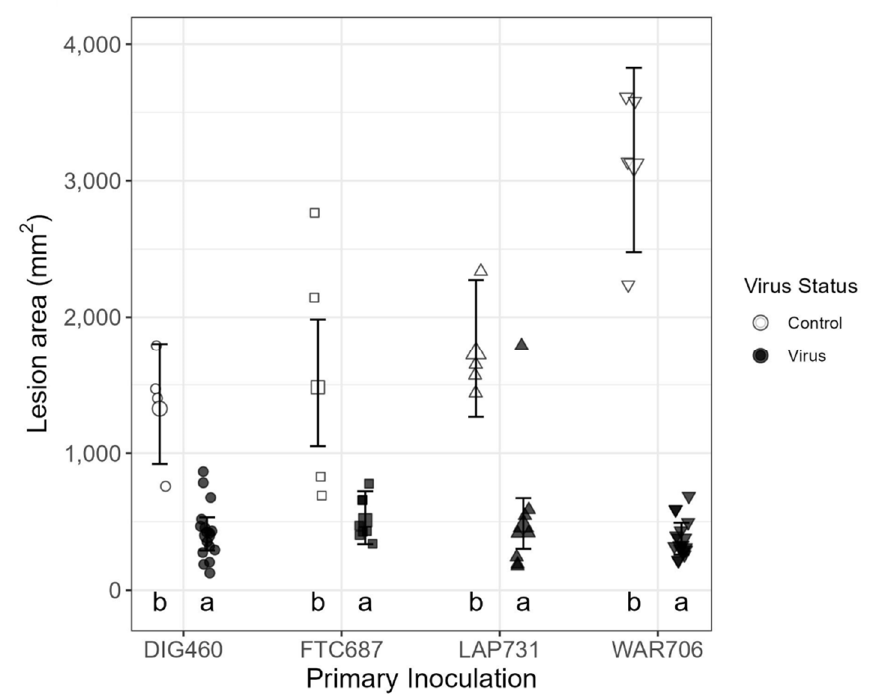
Figure 4. Lesion area by primary inoculation and challenge inoculation with virus or without virus (control) using seedlings. Points with error bars represent estimated marginal means with 95% confidence intervals. Lettering indicates significant differences between challenge inoculation with virus compared to the control. See Material and Methods third paragraph for experimental details. Table 5. Correlation results among all the tested parameters in assay II, using branches.